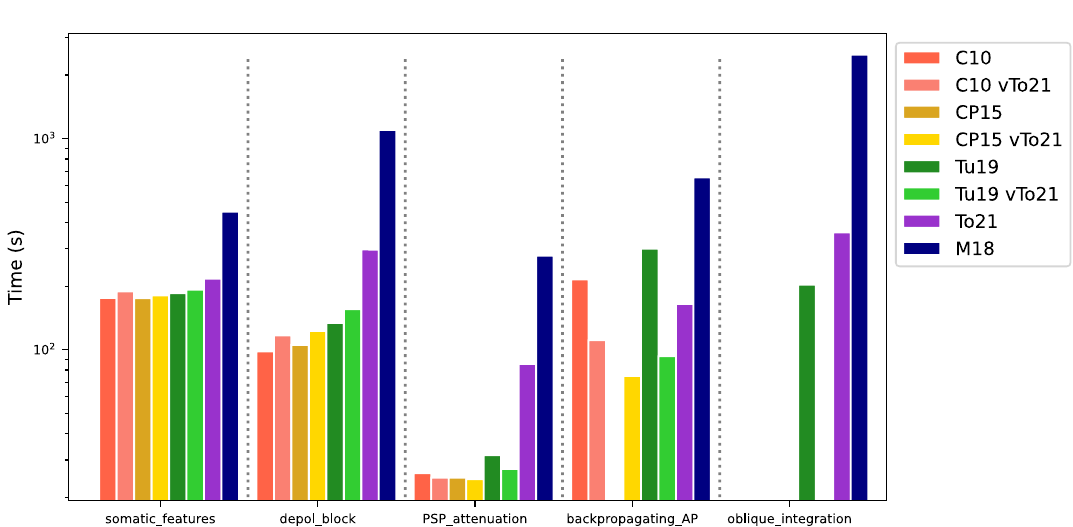
Figure 7. The runtimes of all models for each test. If the model does not pass the test, it is indicated by a blank space. The figure also contains the runtimes of the modified reduced-morphology models, which is indicated as "vTo21" at the end of the model name in the legend (see text for more details). The bAP Test for the CP15 model was implemented by us and therefore we did not measure the